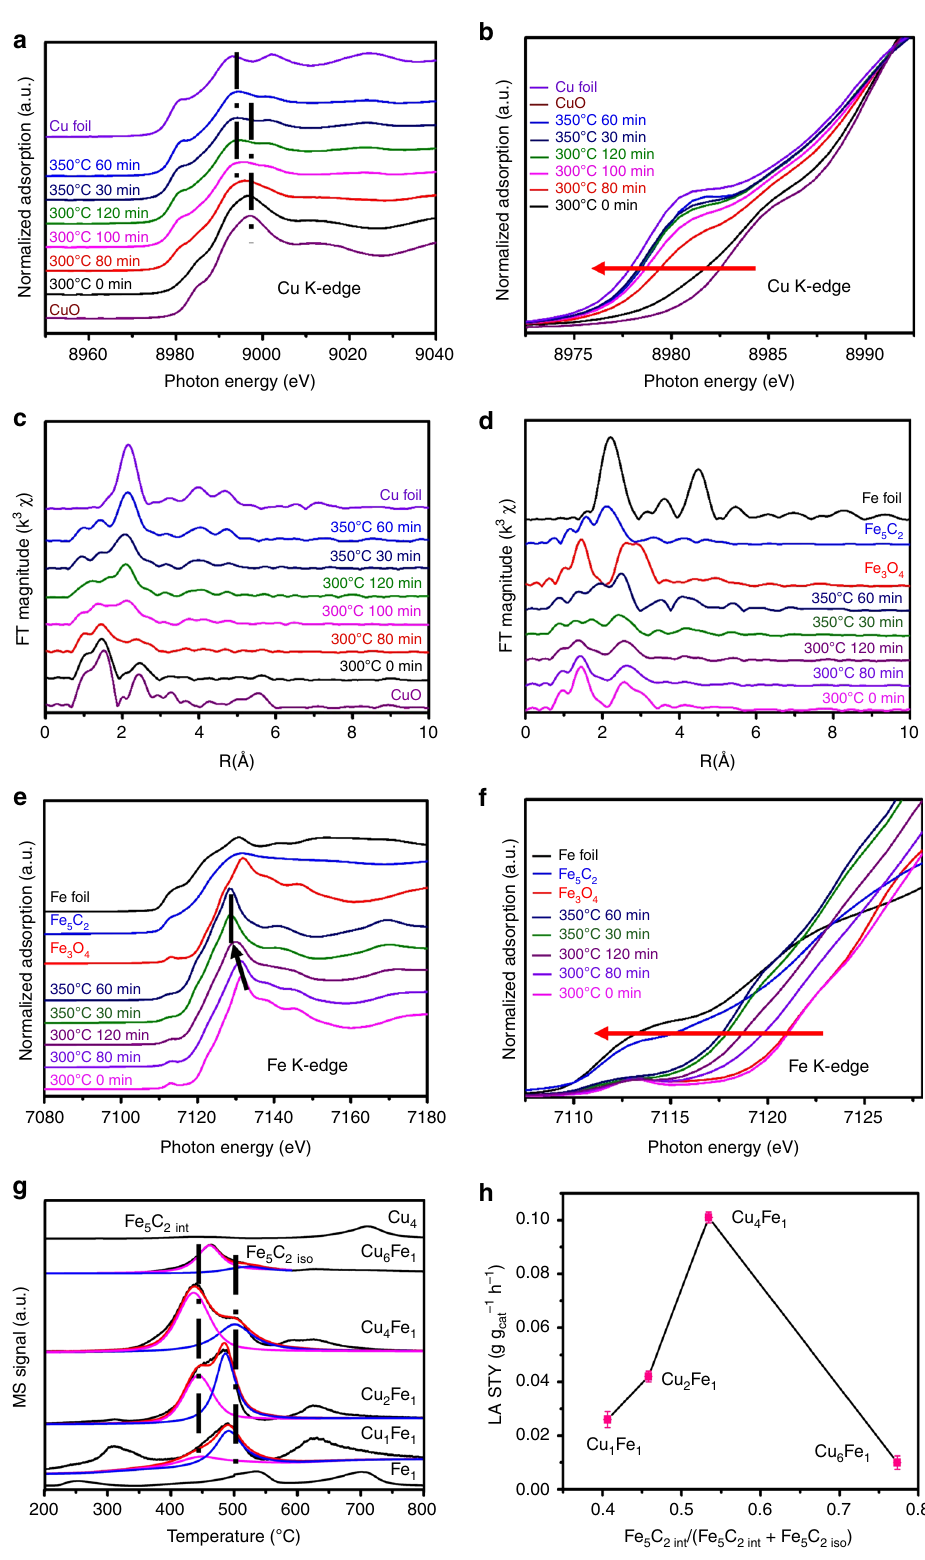
Fig. 4 In situ XAS measurements of Cu 4 Fe 1 catalyst and CO-TPD measurements of Fe 1 , Cu 4 and Cu x Fe y samples. a , e In situ XANES spectra at Cu K-edge and Fe K-edge of Cu 4 Fe 1 Mg 4 -MMO in syngas treatment to obtain Cu 4 Fe 1 catalyst (5% CO + 5% H 2 + 10% CO 2 + 80% He stream; 20 mL min − 1 ) at different temperatures and time points, respectively. b , f Enlarged view of absorption edge selected from ( a , e ). c , d Fourier transform magnitude of k 3 -weighted in situ Cu K-edge and Fe K-edge EXAFS spectra, respectively. g CO-TPD pro fi les of Fe 1 , Cu 4 , and Cu x Fe y samples. h Long-chain alcohols space time yield as a function of Fe 5 C 2int /(Fe 5 C 2int + Fe 5 C 2iso ). Fe 5 C 2int : interfacial Fe 5 C 2 ; Fe 5 C 2iso : isolated Fe 5 C 2 . The error bars are between 0.002 and